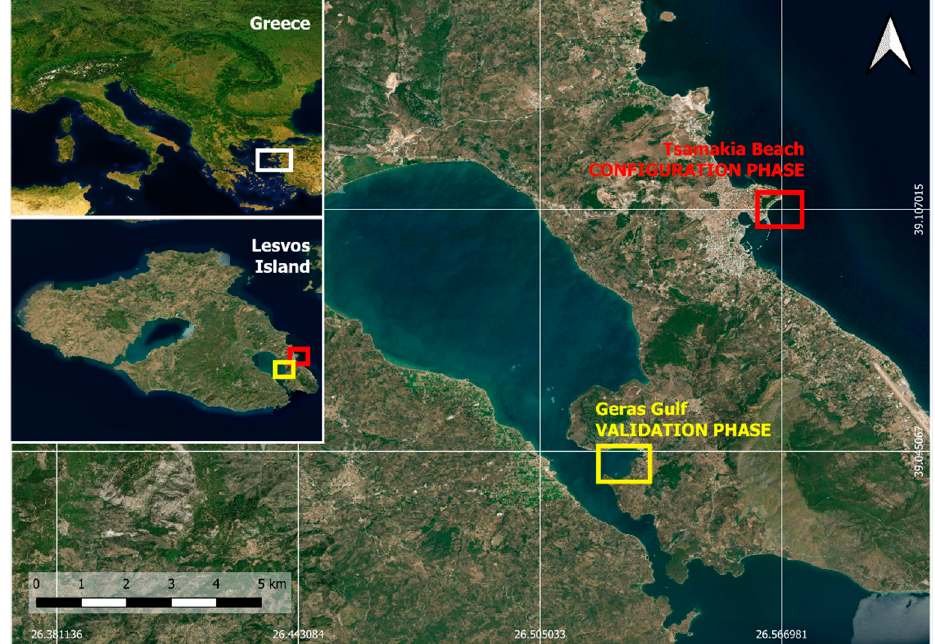
Figure 1. Map of the south-eastern part of Lesvos Island (Greece), showing the study sites where controlled experiments were performed: Tsamakia Beach in Mytilene (red) and Geras Gulf (yellow). The configuration phase of this study was conducted on Tsamakia Beach, whilst the validation phase was performed in Geras Gulf.